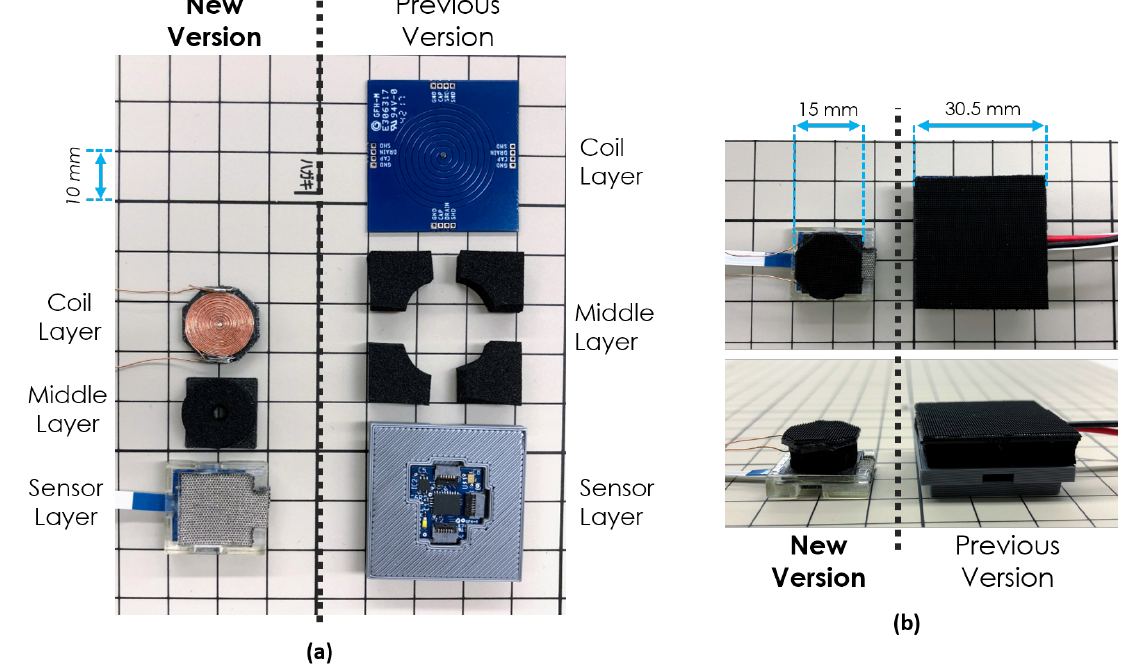
Figure 4. New and previous versions of the sensor module compared side by side. ( a ) Before assembly, with layer references, top view. ( b ) After assembly, top and side